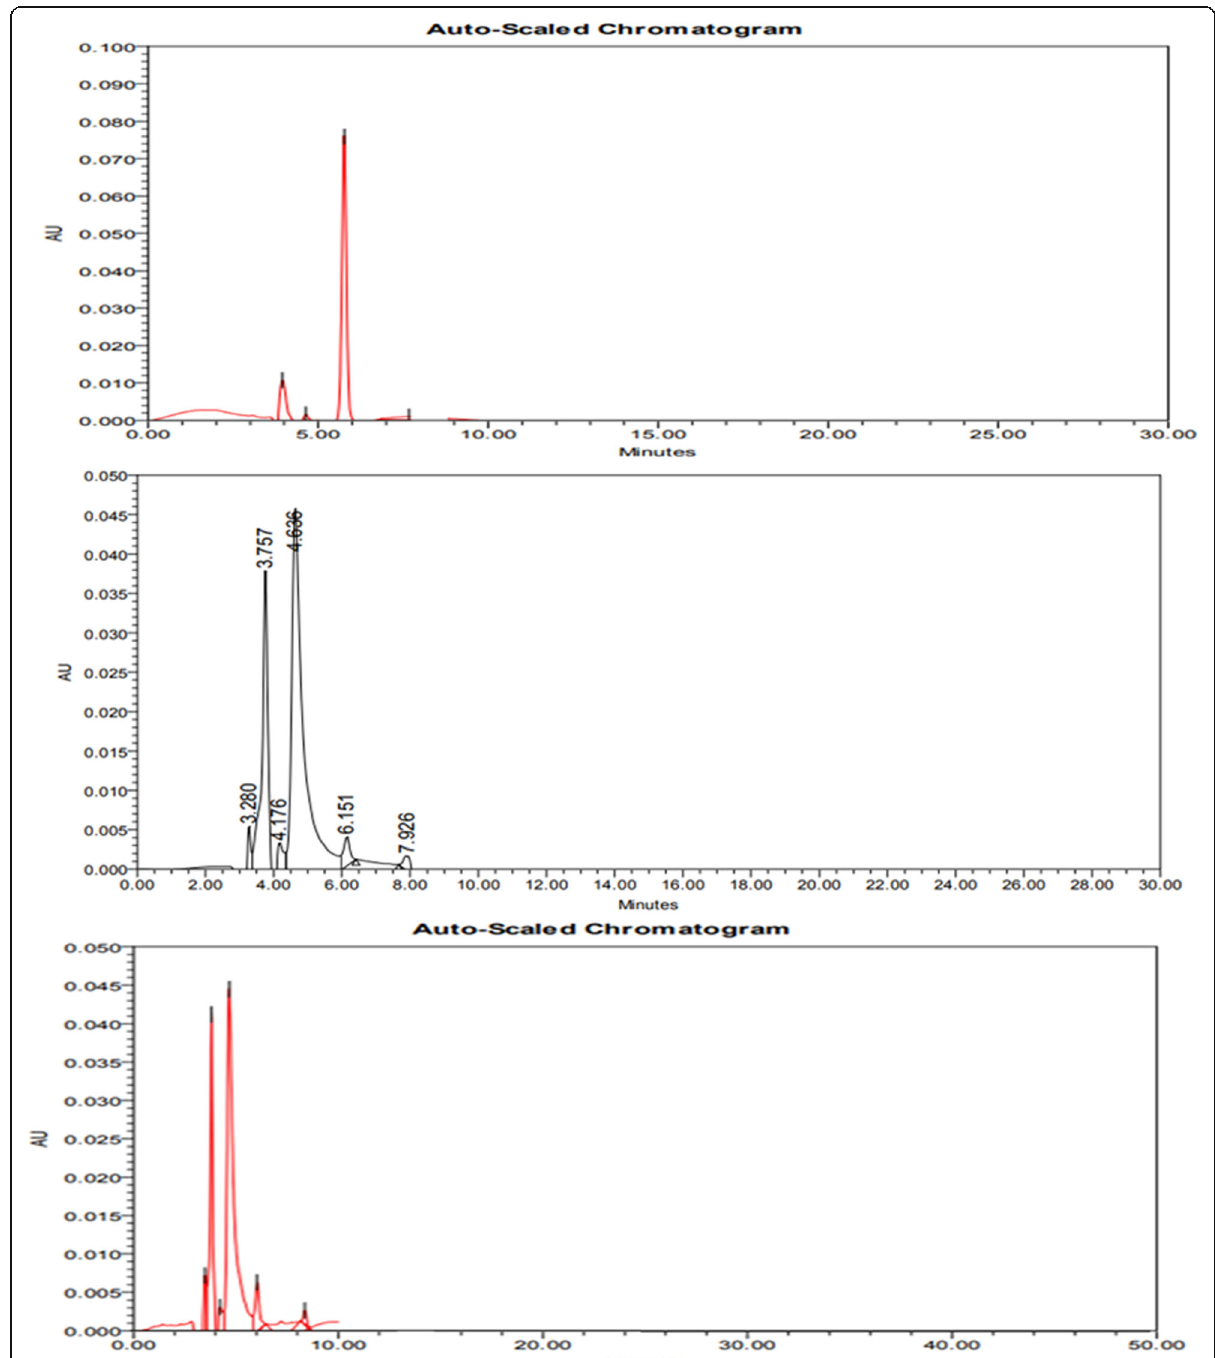
Fig. 3 HPLC chromatograms obtained by forced degradation of the Orlistat in various conditions as required by ICH guidelines for stability